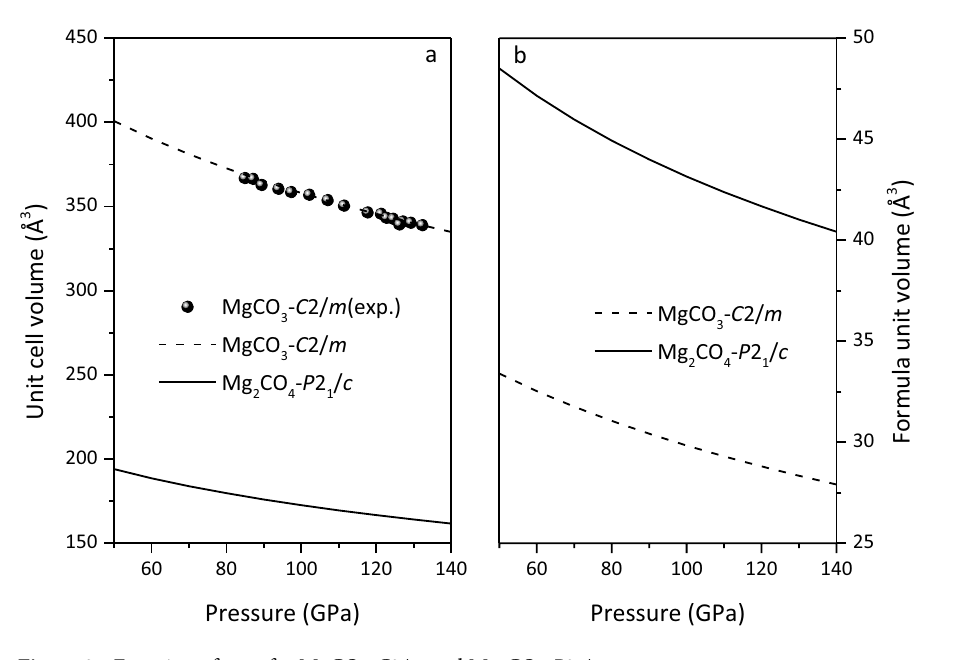
Figure 3. Equation of state for MgCO 3 - C 2 /m and Mg 2 CO 4 - P 2 1 /c